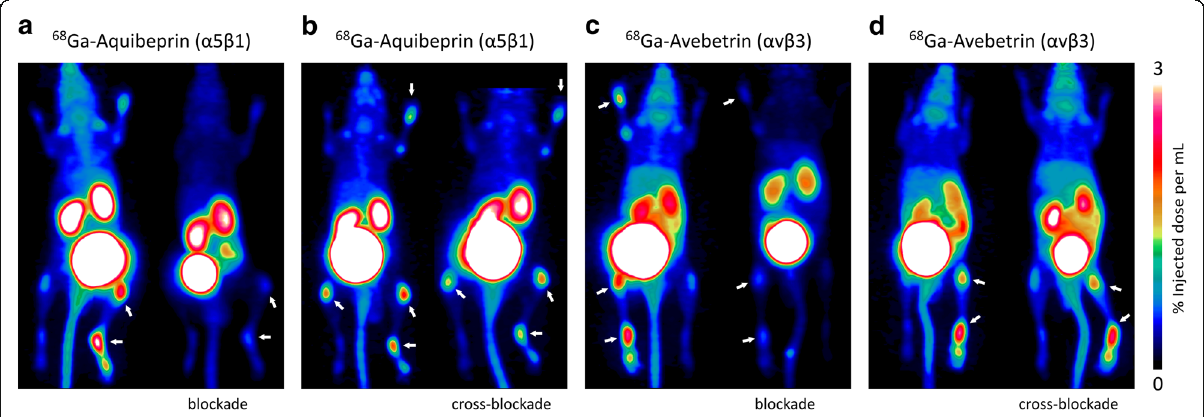
Fig. 2 Subtype-specific integrin PET imaging in arthritic mice. a , b α 5 β 1 integrin PET using 68 Ga-Aquibeprin. c , d α v β 3 integrin PET using 68 Ga- Avebetrin. Each of the images a – d shows two independent scans of the same mouse (different animals are shown in a – d ). The arthritic joints are indicated by the arrows. The saturation of the receptor binding capacity by means of co-injection of a large dose (30 nmol) of unlabeled compound (blockade) resulted in a virtually complete reduction of the uptake in arthritic joints for both tracers, confirming the specificity of the PET imaging ( a , c ). The cross-blockade experiments confirmed the subtype-selectivity of α 5 β 1- and α v β 3 integrin PET: The co-injection of 30 nmol Avebetrin did not substantially affect the α 5 β 1 integrin imaging with 68 Ga-Aquibeprin, while the minuscule reduction of the signal is likely related to a residual α 5 β 1 activity (39 nM) of Avebetrin ( b ). The co-injection of 30 nmol Aquibeprin did not affect α v β 3 integrin imaging with 68 Ga-Avebetrin ( d